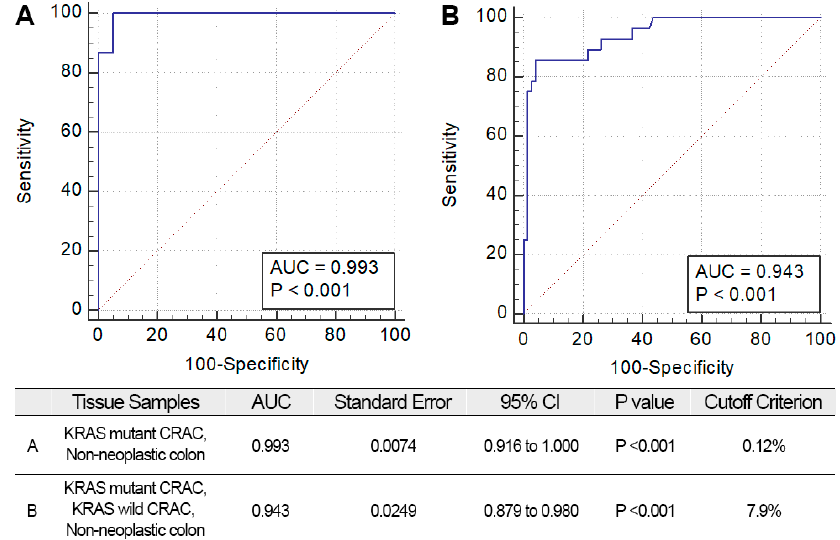
Figure 2. Receiver operating characteristic (ROC) curves for ddPCR. Optimal cutoff criteria and the area under curve (AUC) results are shown. ( A ) ROC curves using KRAS results from KRAS mutant CRAC and non-neoplastic colon ( B ) ROC curves using KRAS results from KRAS mutant CRAC, KRAS wild CRAC, and non-neoplastic colon.